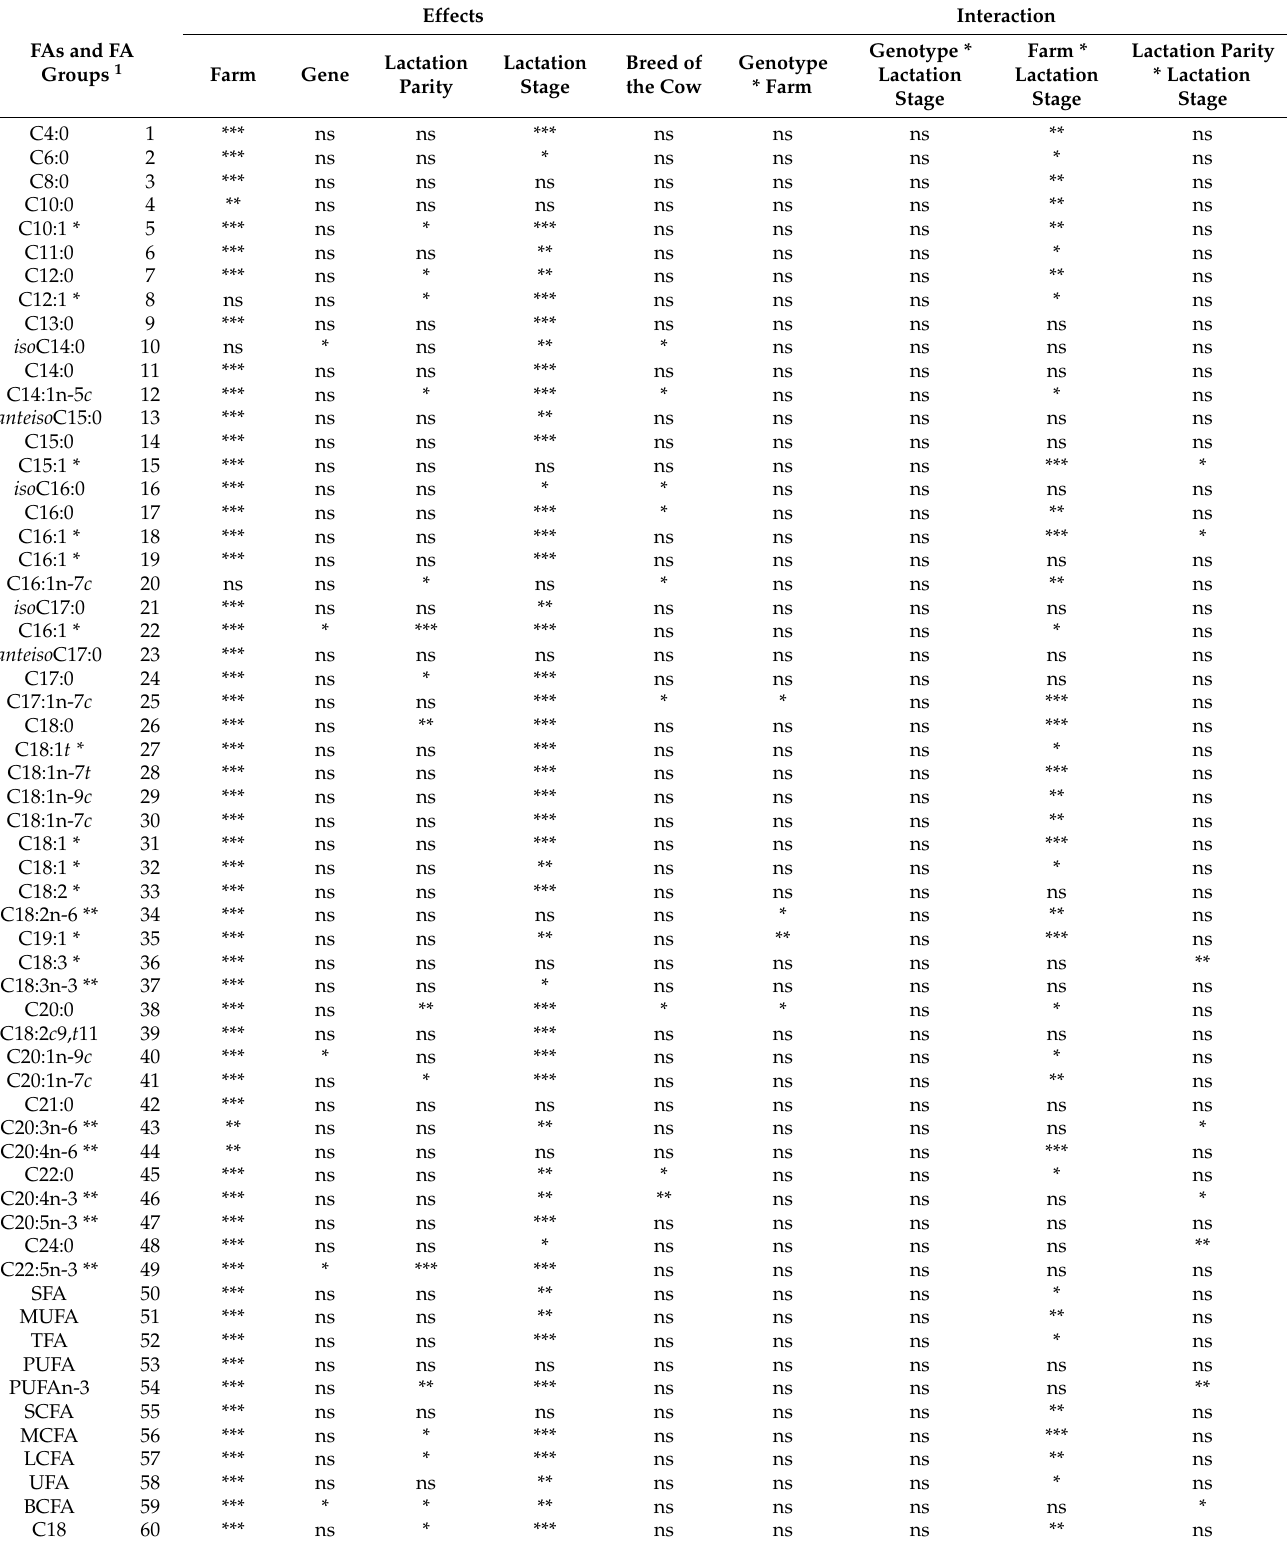
Table 5. Effects on the fatty acid (FA) proportions ( p- values)— FASN